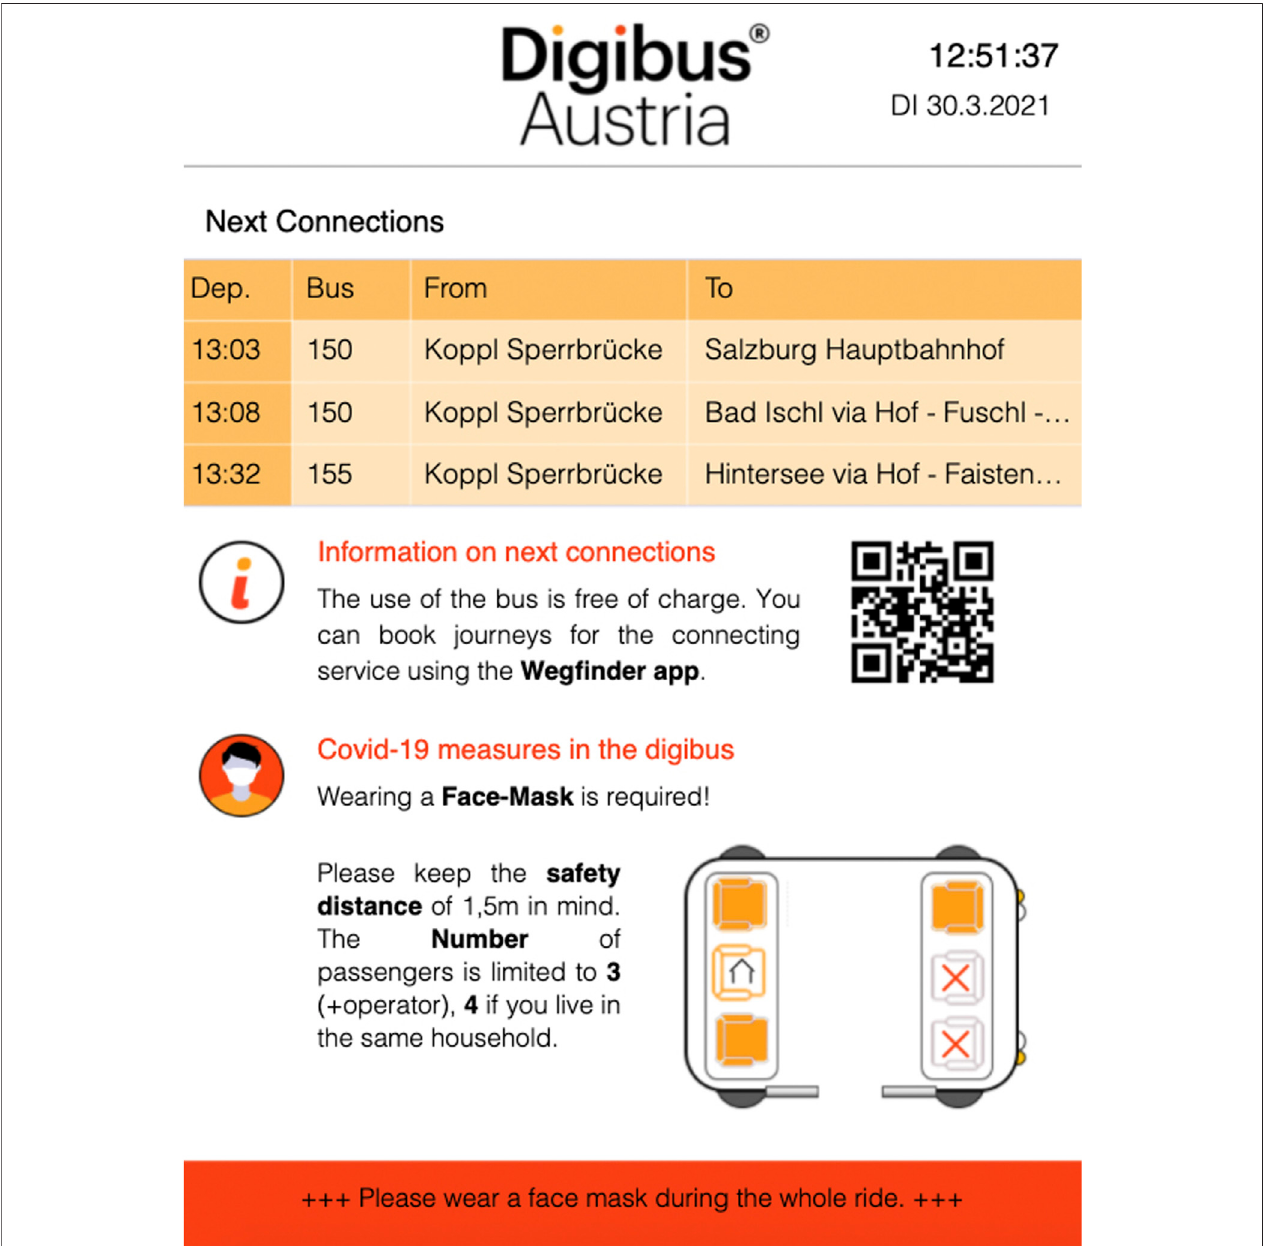
FIGURE 11 | Study 3: The in-shuttle information